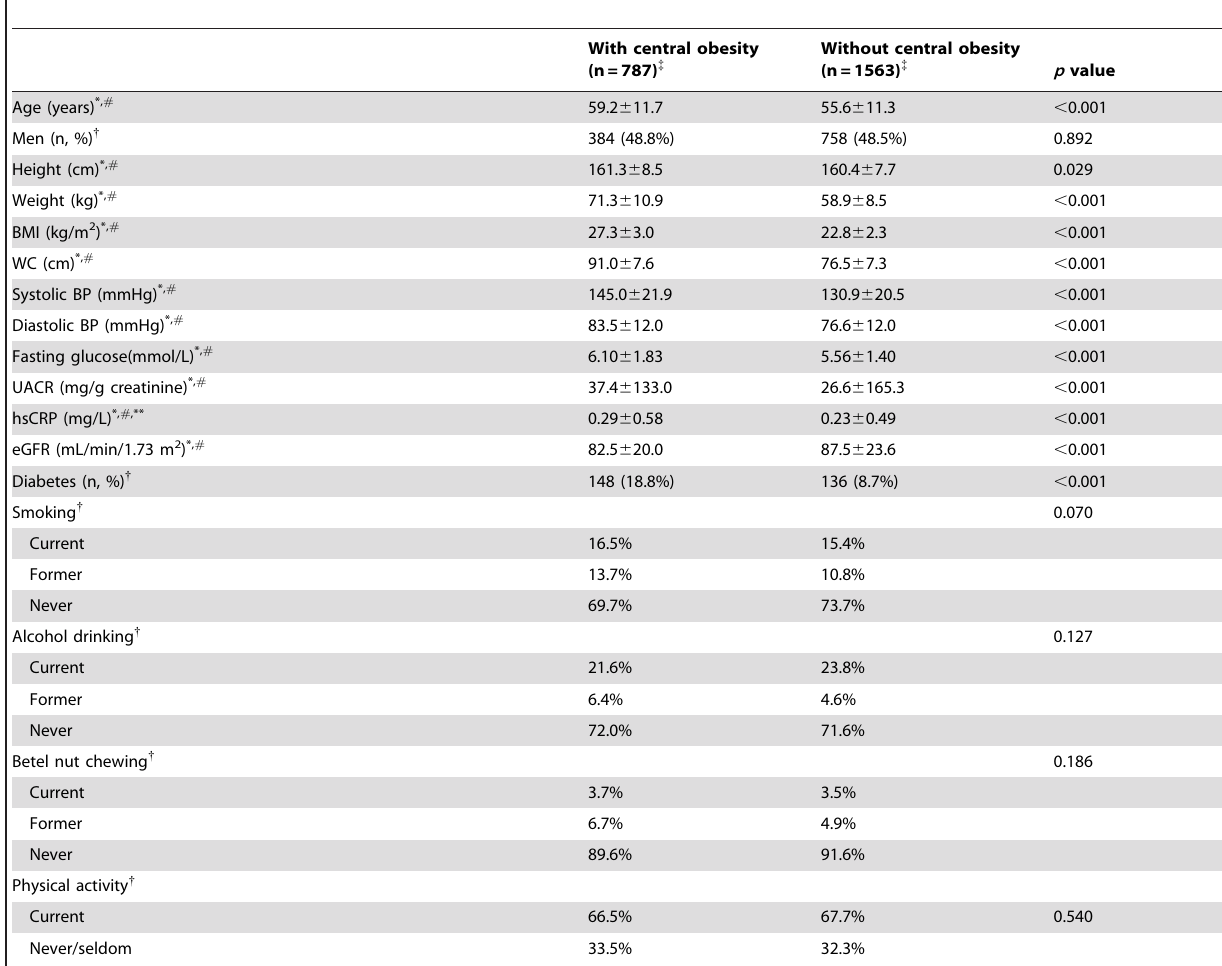
Table 1. Baseline characteristics according to central obesity status (n =2350) {